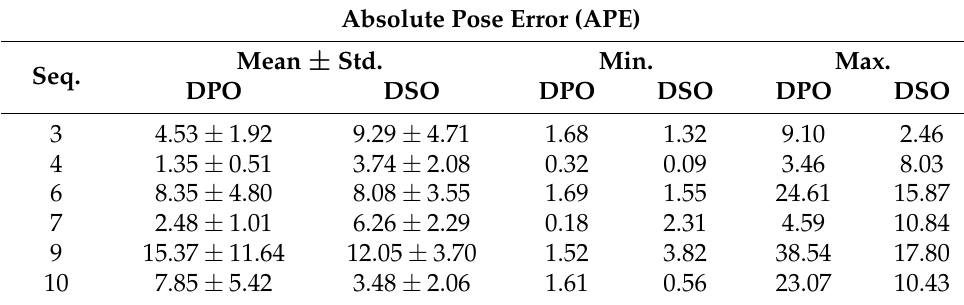
Table 4. Comparison of mean error, standard deviation and minimum and maximum error of the six analyzed sequences between DPO and Stereo DSO. Absolute Pose Error (APE) Mean ± Seq.